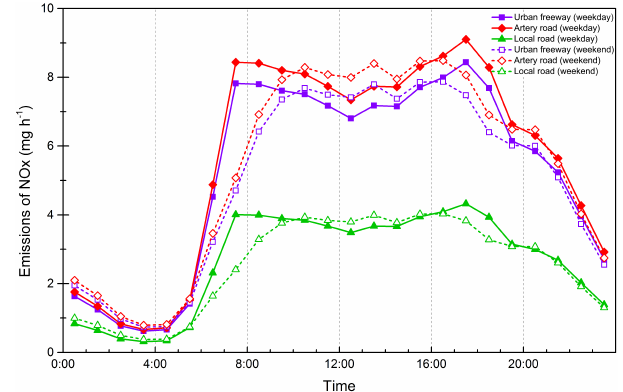
Figure 7. The vehicle emission contribution of different vehicle